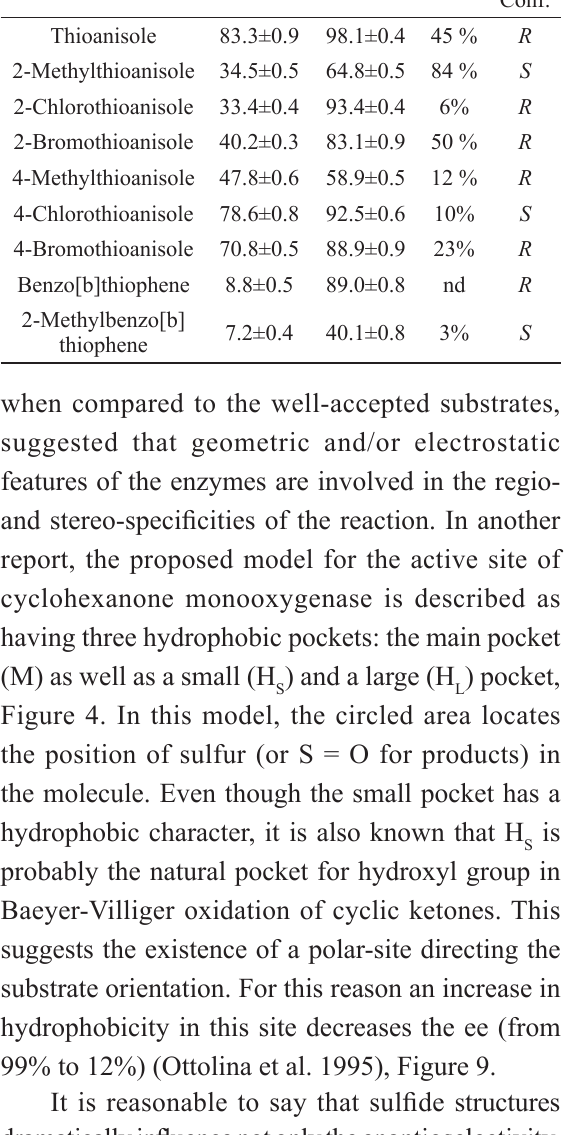
Reaction rates for different substrates (μmol/min/g) with wild type (native SMO) and engineered SMO enzymes (Eng.